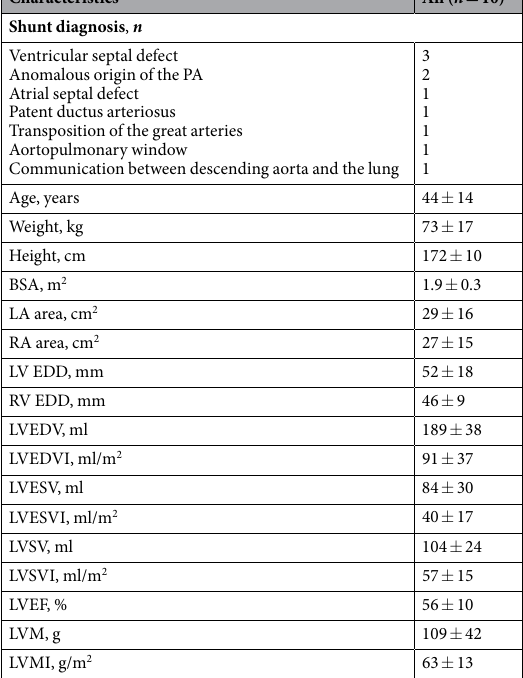
Table 2. Baseline characteristics for patients with known shunts. Data presented as mean ± standard deviation. BSA = body surface area, LA = left atrium; LVEDD = left ventricular end diastolic diameter, LVEDV = left ventricle end diastolic volume, LVESV = left ventricle end systolic volume, LVSV = left ventricle stroke volume, LVEF = left ventricle ejection fraction, LVM = left ventricular mass, RA = right atrium, RVEDD = right ventricular end diastolic diameter. An ‘I’ indicates volumes and mass indexed to BSA.